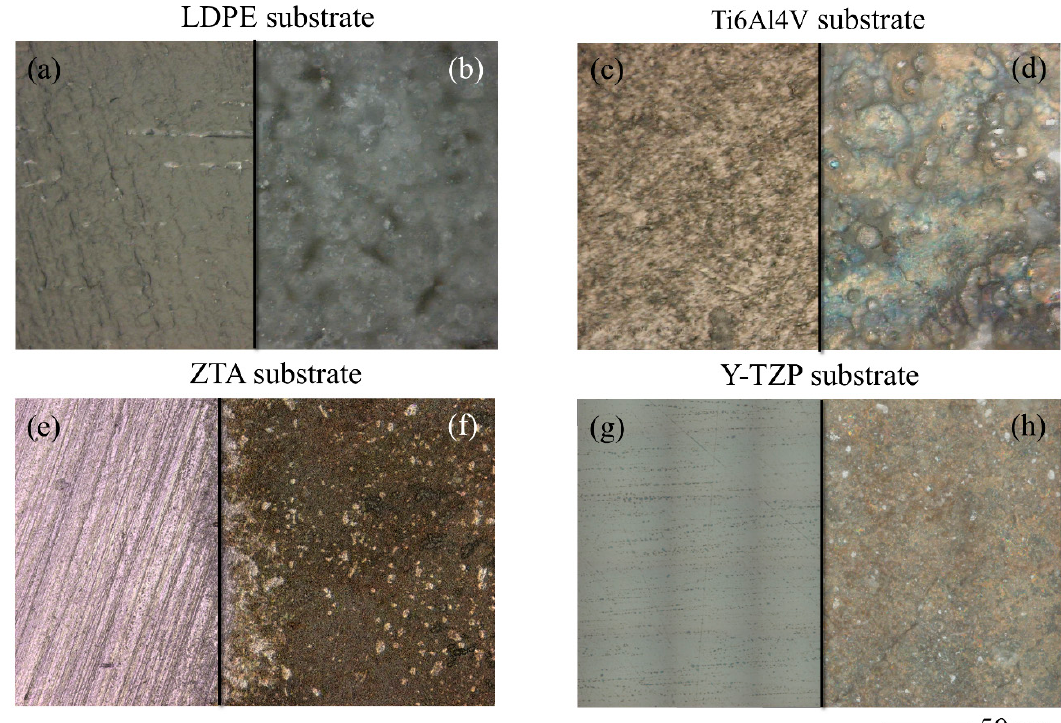
Figure 1. Laser microscope substrate surface images: untreated LDPE ( a ) and coated LDPE ( b ), untreated Ti6Al4V ( c ) and coated Ti6Al4V ( d ), untreated ZTA ( e ) and coated ZTA ( f ), and untreated Y-TZP ( g ) and coated Y-TZP ( h ).